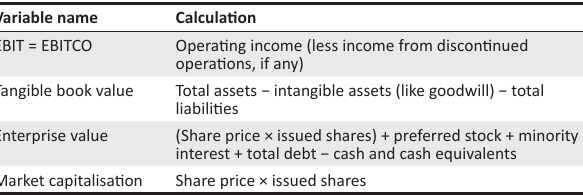
TABLE 2: Variable